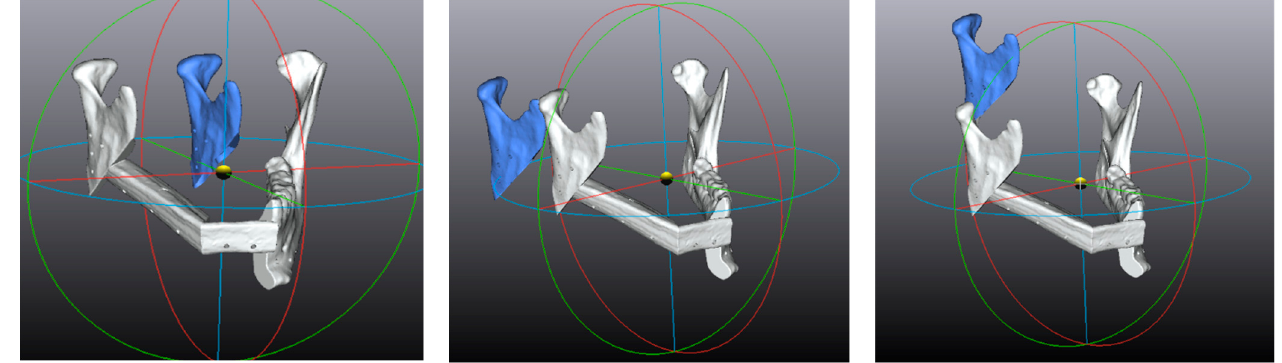
Figure 7. Examples of translation vectors obtained with arbitrary values (50 mm): from left to right, X, Y, and Z.